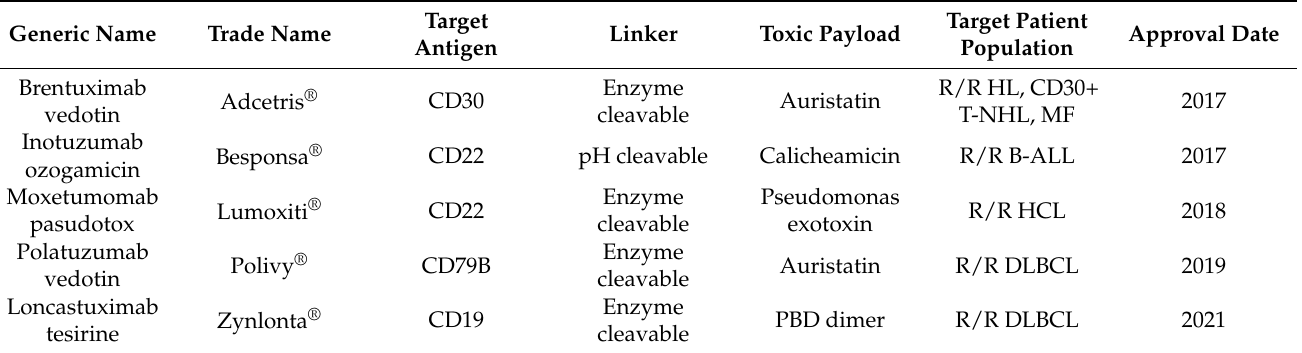
Table 1. Antibody–drug conjugates and immunotoxins approved for the therapy of lymphoprolifera- tive